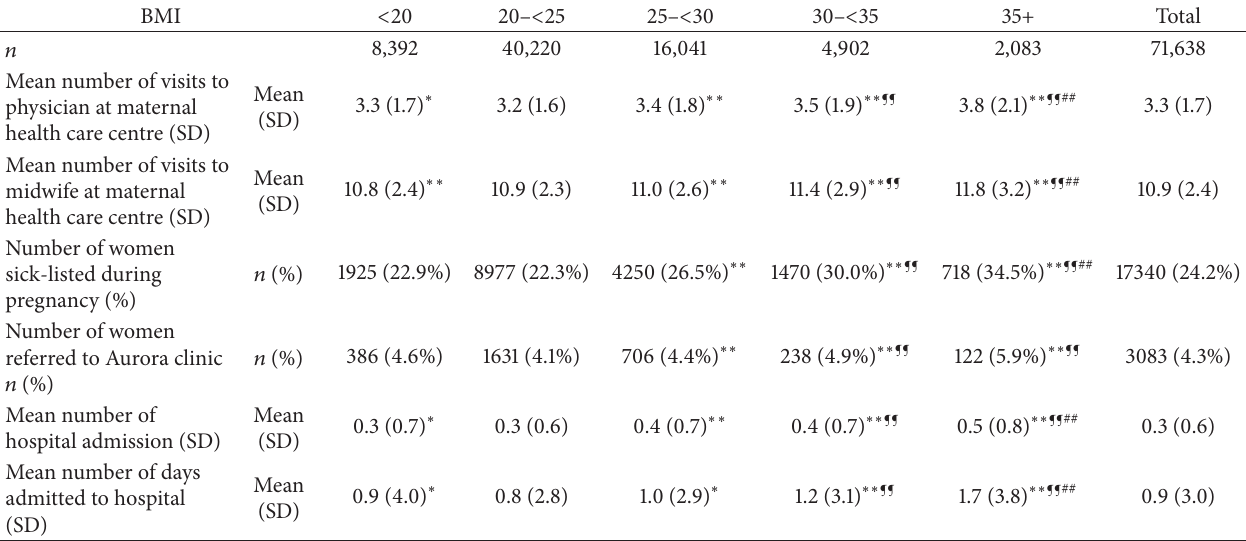
Table 2: Health care consumption during